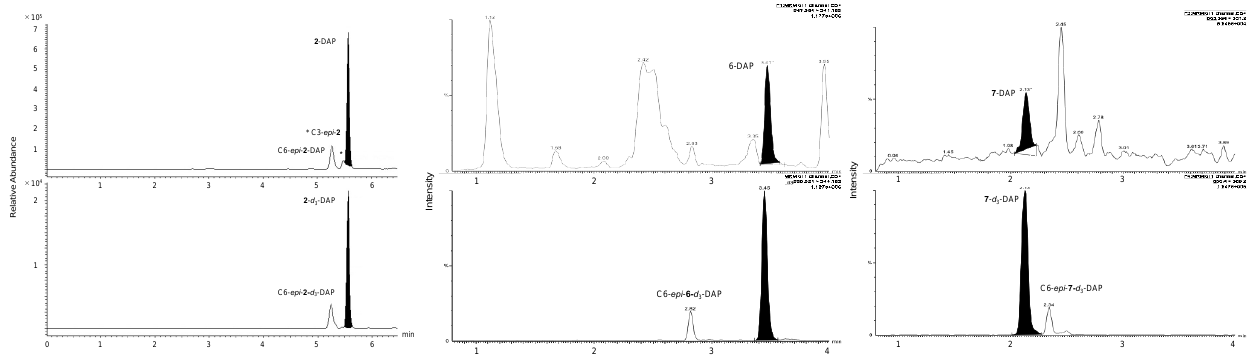
Figure 5. SRM chromatograms for D 3 derivatives 2 , 6 , and 7 in pooled human serum. The concentrations of 2 , 6 , and 7 in human serum were calculated to be 5.1 ng/mL, 38.3 pg/mL, and 8.9 pg/mL, respectively, based on the area ratios of the detected peaks. The concentrations of 2 and 6 were in agreement with previously reported values [37], while this is the first quantification of 1α-lactone 7 in human serum.